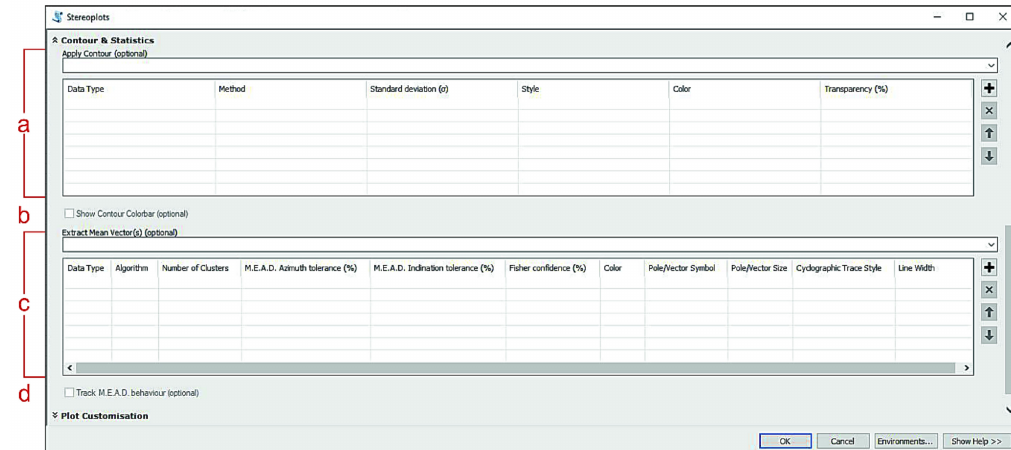
Figure 3. Expanded ‘Contour & Statistics’ submenu of ‘Stereoplots’ tool. ( a ) ‘Apply Contour’ Value Table; the user can choose the preferred contour density function under the ‘Method’ column, and set other parameters such as standard deviation, style, colour, and transparency. ( b ) Show a colour bar referred to the applied contour. ( c ) ‘Extract Mean Vectors’ Value Table; the algorithm-control parameters are ‘Algorithm’, to choose the preferred algorithm, ‘Number of Clusters’, Azimuth and Inclination tolerances and ‘Fisher confidence’. The other parameters gather settings for graphic appearance. ( d ) Track Mean Extractor from Azimuthal Data (M.E.A.D.) clustering behaviour option will only apply on clusters extracted by mean of the M.E.A.D. clustering process (see “‘Stereoplots’ tool algorithms” subparagraph for